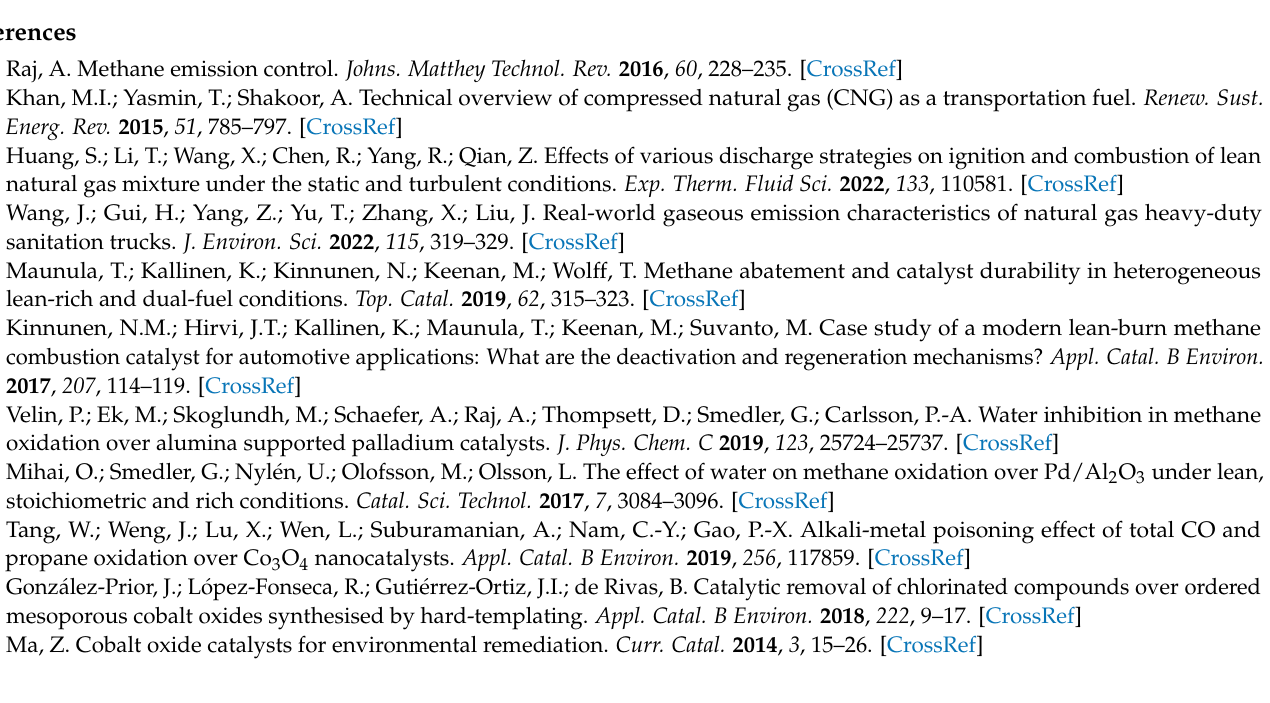
catalysts, Figure S3: Raman spectra of the bulk Co 3 O 4 catalysts, Figure S4: CH 4 -TPRe profiles of the bulk Co 3 O 4 catalysts, Figure S5: Close-up view of the CH 4 -TPRe profiles in the 300–500 ◦ C range of the CC catalyst before and after the stability